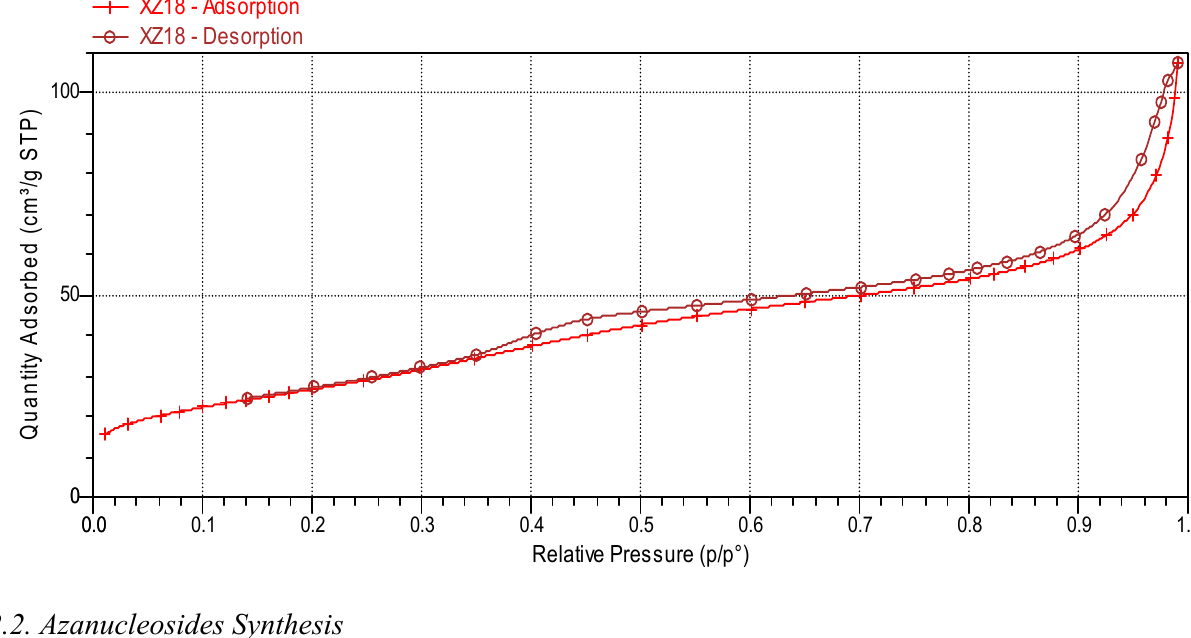
Figure 3. Sulphated zirconia nitrogen adsorption-desorption